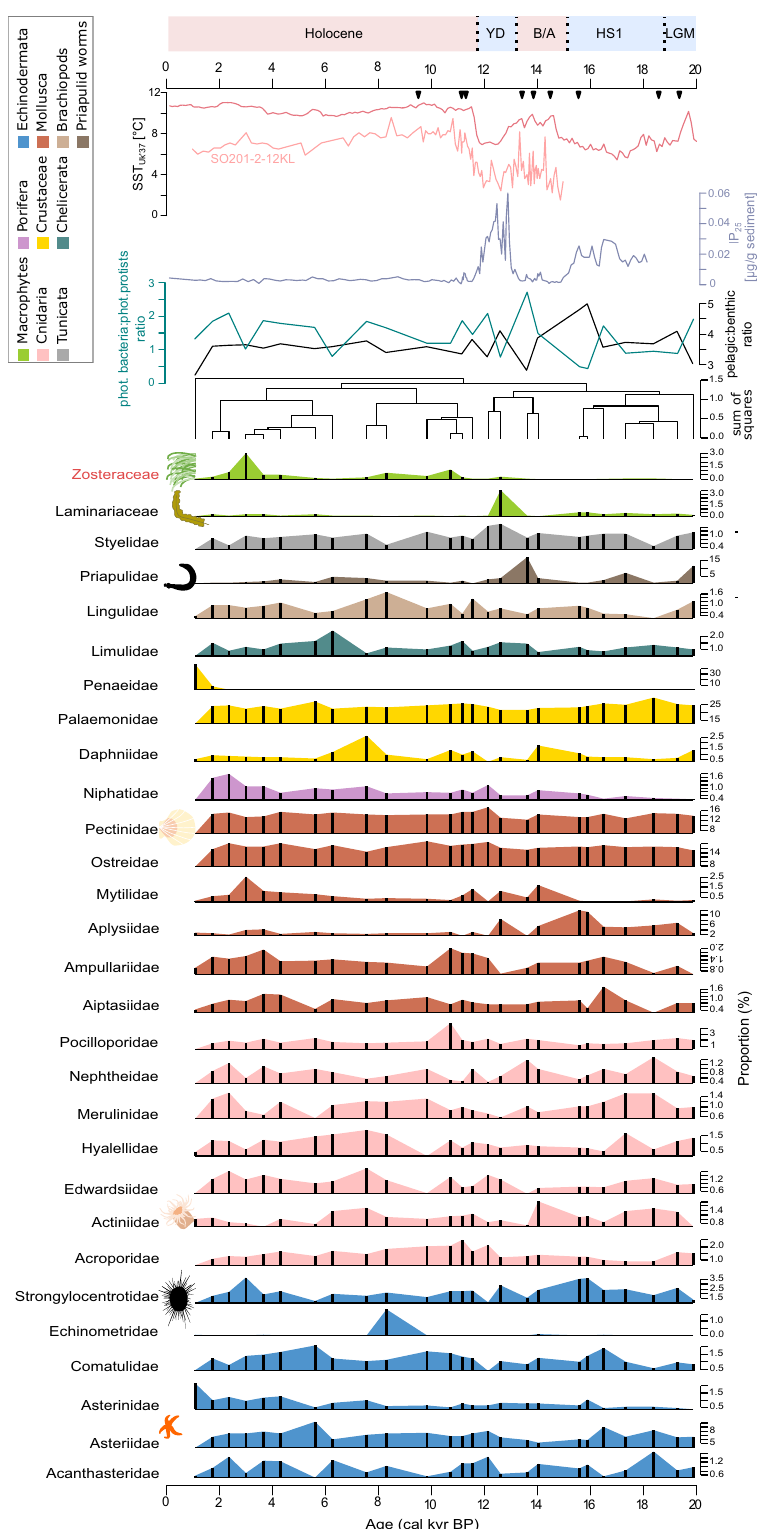
Fig. 4 | Sed aDNA record of benthic families of core SO201-2-12. Only families representedinatleastthreesamplesandbyatleast1.5%proportionofreadcounts after resampling are shown. The dendrogram (based on constrained hierarchical clustering) and IP 25 concentrations from the same core 16 and sea-surface tem- perature (SST Uk ‘ 37 ) reconstructions of the Northwest Paci fi c 52 (light red) and Northeast Paci fi c 97 (dark red) are added for comparison. Zosteraceae, which are signi fi cant, and positively correlated with SST Uk ’ 37 , are highlighted in red. The